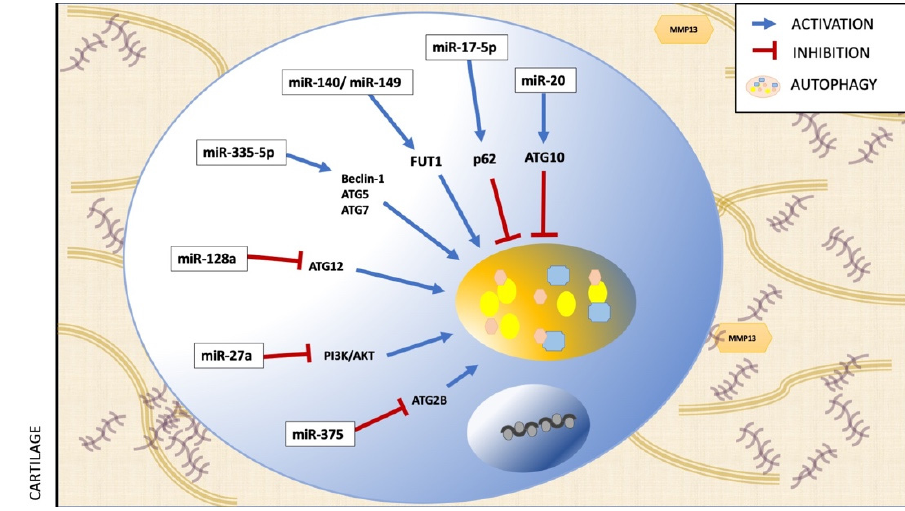
Figure 4. Regulation of autophagy by miRs in